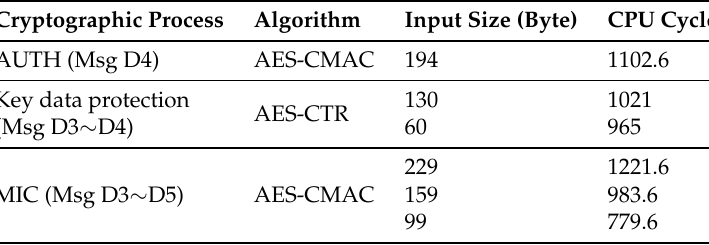
Table 4. Computation cost of STA in the proposed